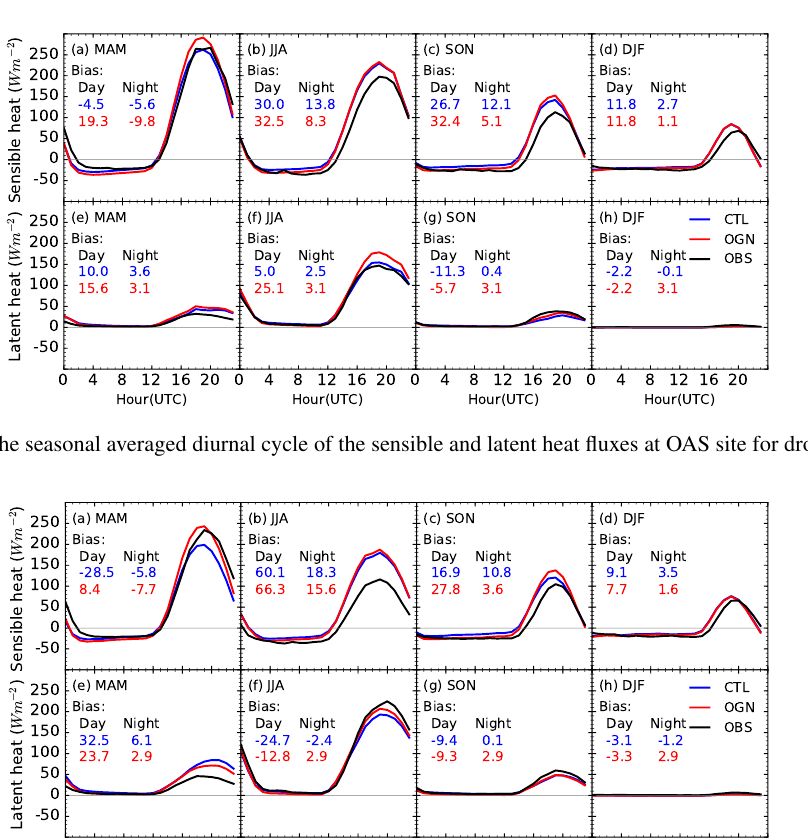
years, the summer energy imbalance ( ∼ 15 W m − 2 ) is nearly equal to the high bias in sensible heat flux ( ∼ 15 W m − 2 )